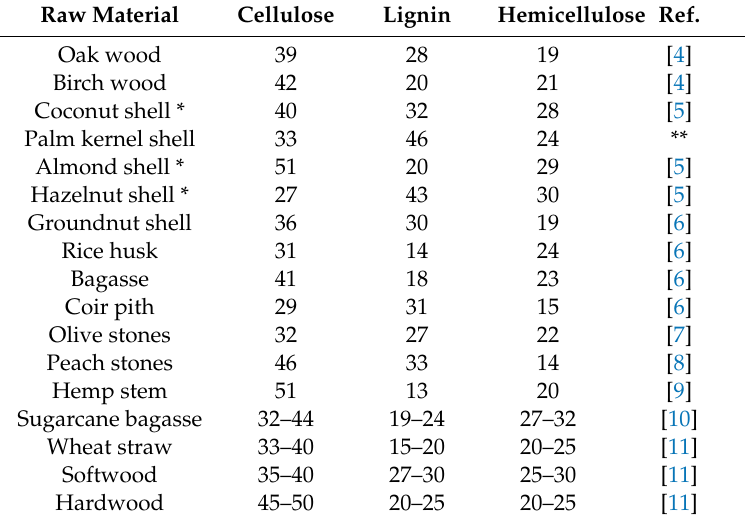
Table 1. Biopolymer composition of selected lignocellulosic materials used for AC preparation (wt%, dry